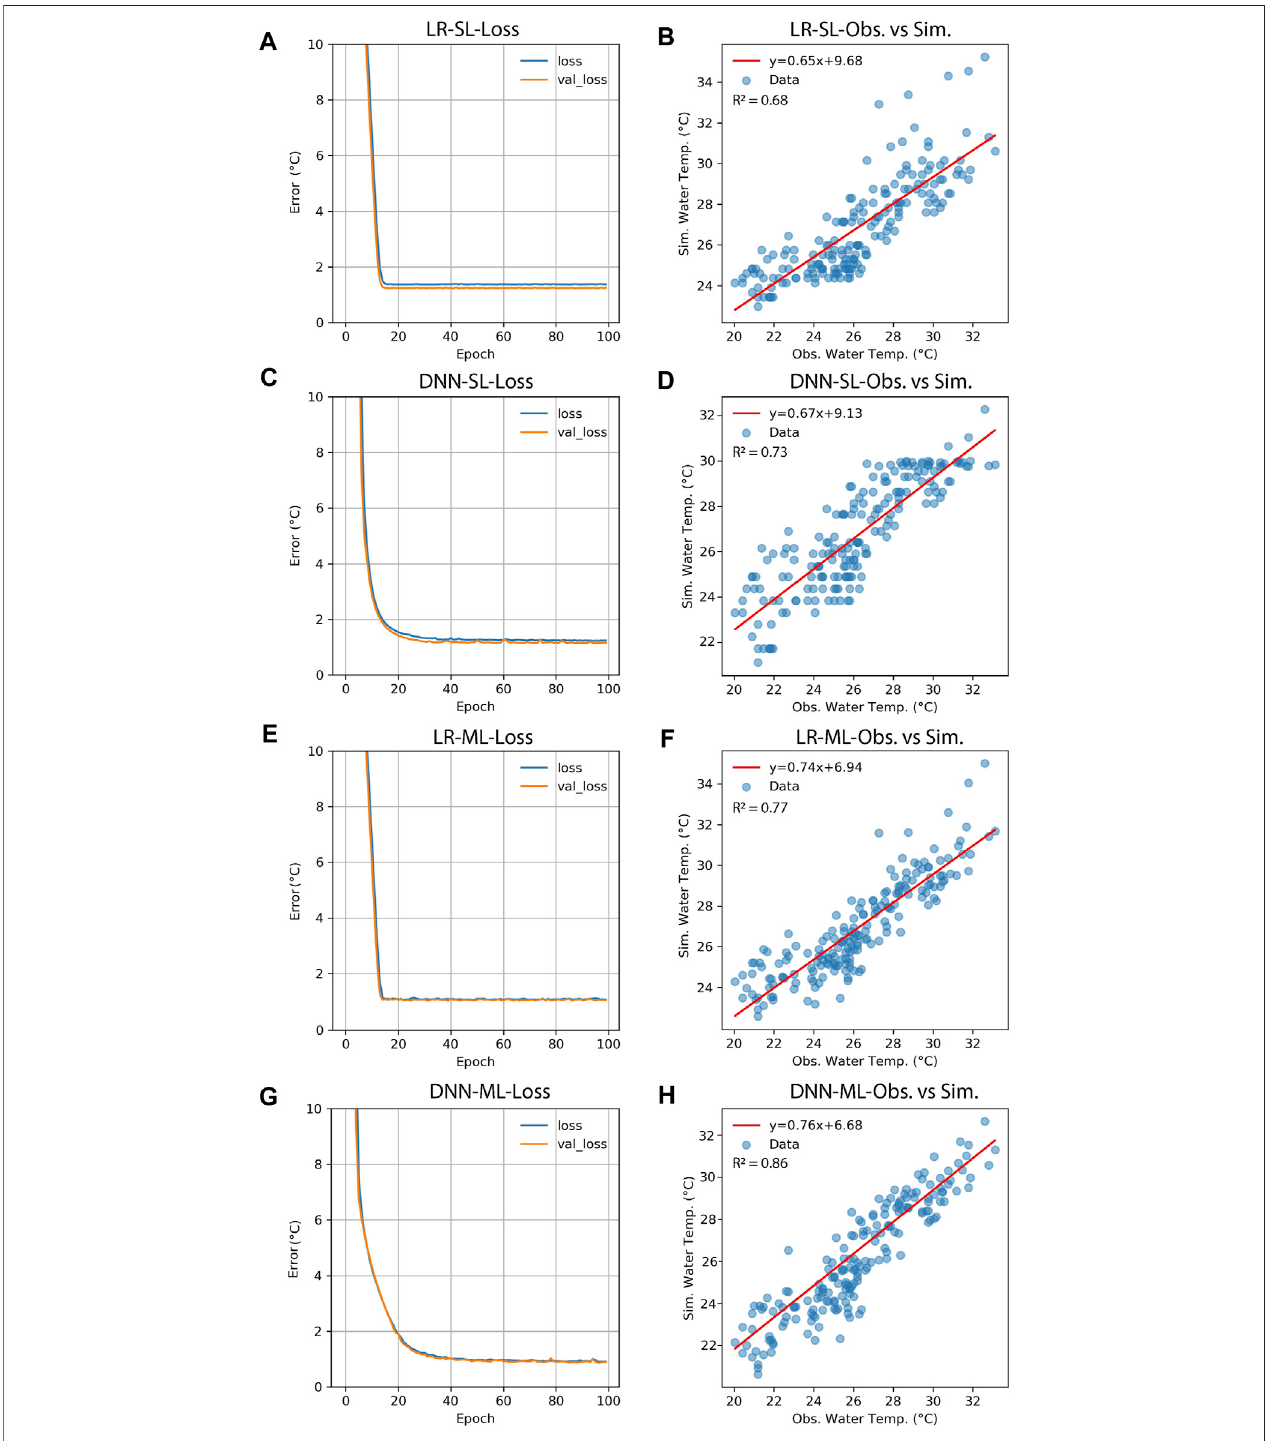
FIGURE4 | Model training and testing performance forfour learning approaches including the linear regression (LR) and deep neural network (DNN)algorithms for single-layer (SL) and multiple layer (ML) conditions. Panels a, c, d, and g show the loss functions (MAE values) for the training and validation data sets and panels b, d, f, and h show the performance of the models in predicting the water temperatures.